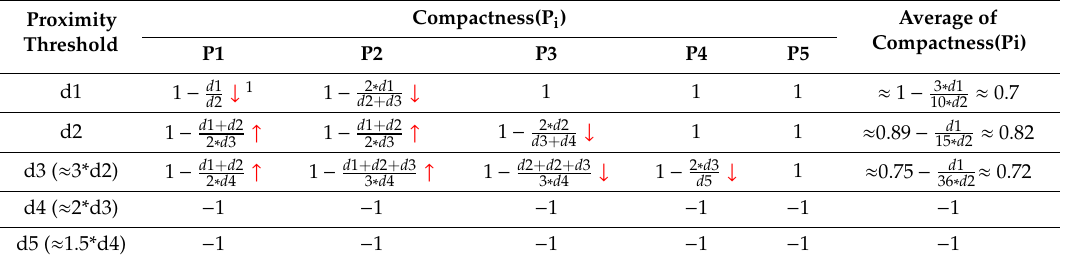
1 Red arrows represent changes in Compactness ( Pi ) compared with previous grouping results: upward pointing arrows indicate larger values and downward pointing arrows indicate smaller